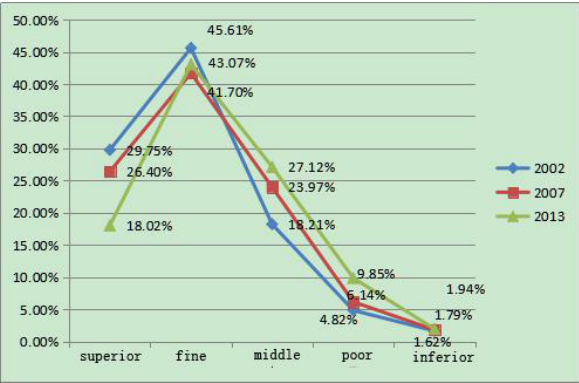
Figure 4 ecological environment area scale map in Lu